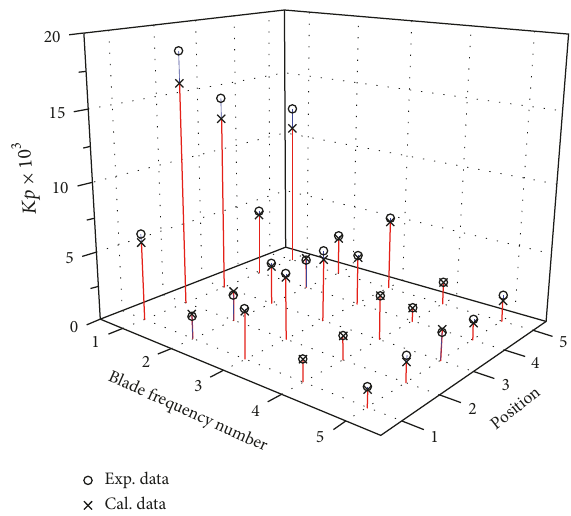
Figure 7: Comparisons between the experiment values and calcu- lation results of 1st propeller.